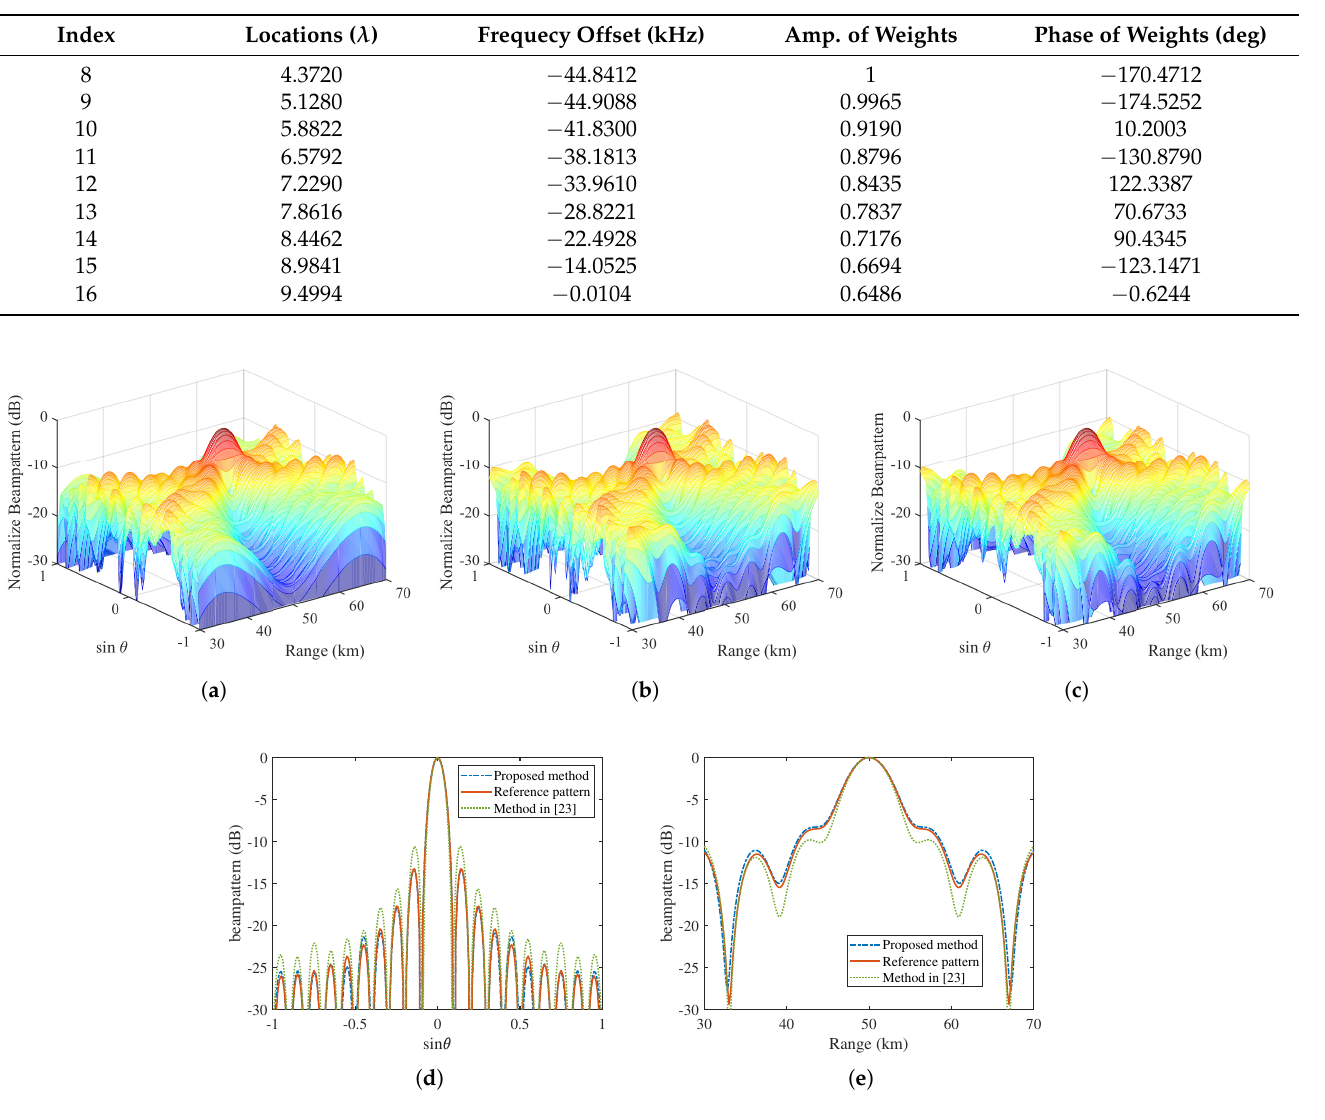
Figure 4. The comparison of patterns generated by different sparse SFDA methods. ( a ) The 3D reference pattern. ( b ) The 3D reconstructed pattern obtained by using the method in [23]. ( c ) The 3D reconstructed pattern obtained by using proposed method. ( d ) The cross section of the pattern along angle dimension. ( e ) The cross section of the pattern along range